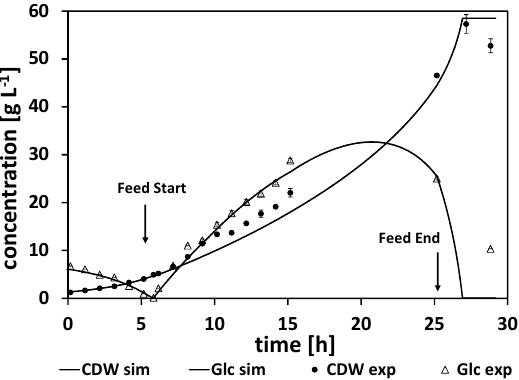
Figure 6. Time course of the glucose and biomass concentration for fed-batch 1; symbols mark samples; the samples were measured as three technical replicates; lines mark the adapted simulated cultivation course (Model B); constant feeding rate of 12 mL h − 1 .